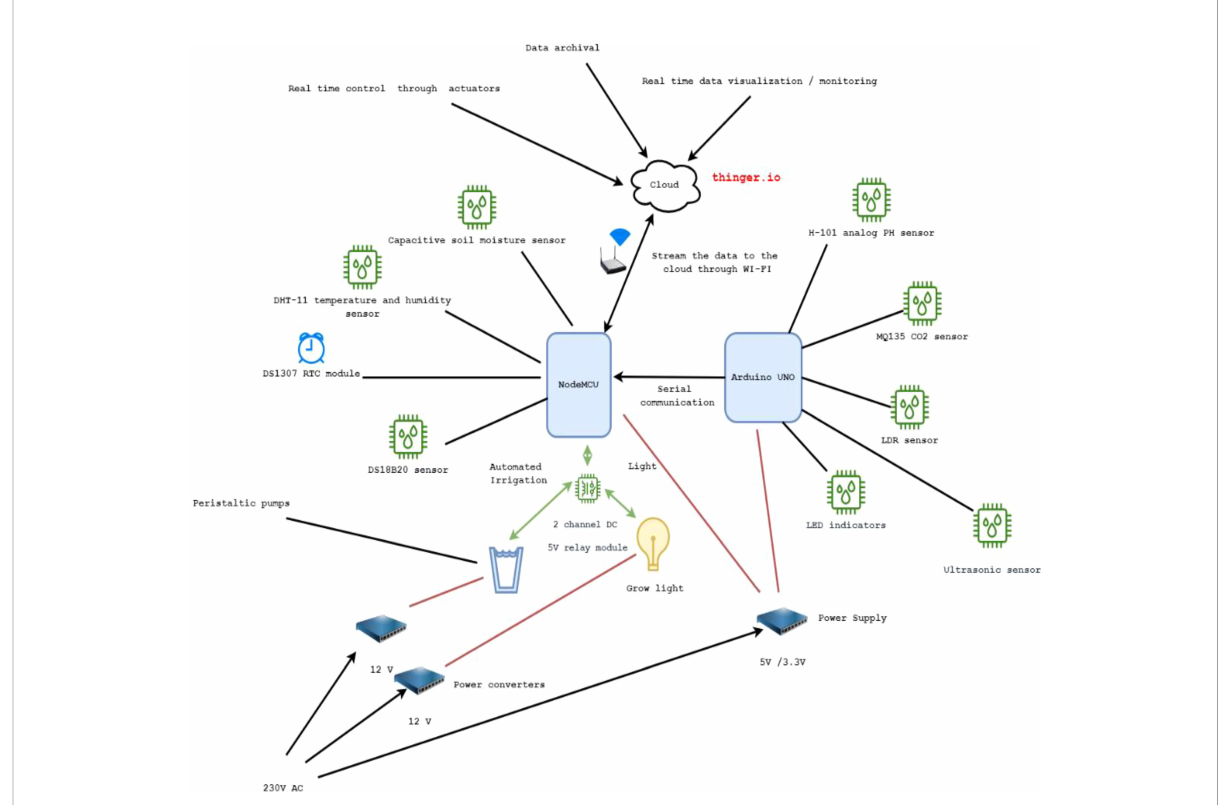
FIGURE 6 Block diagram of our platform with all the connections.